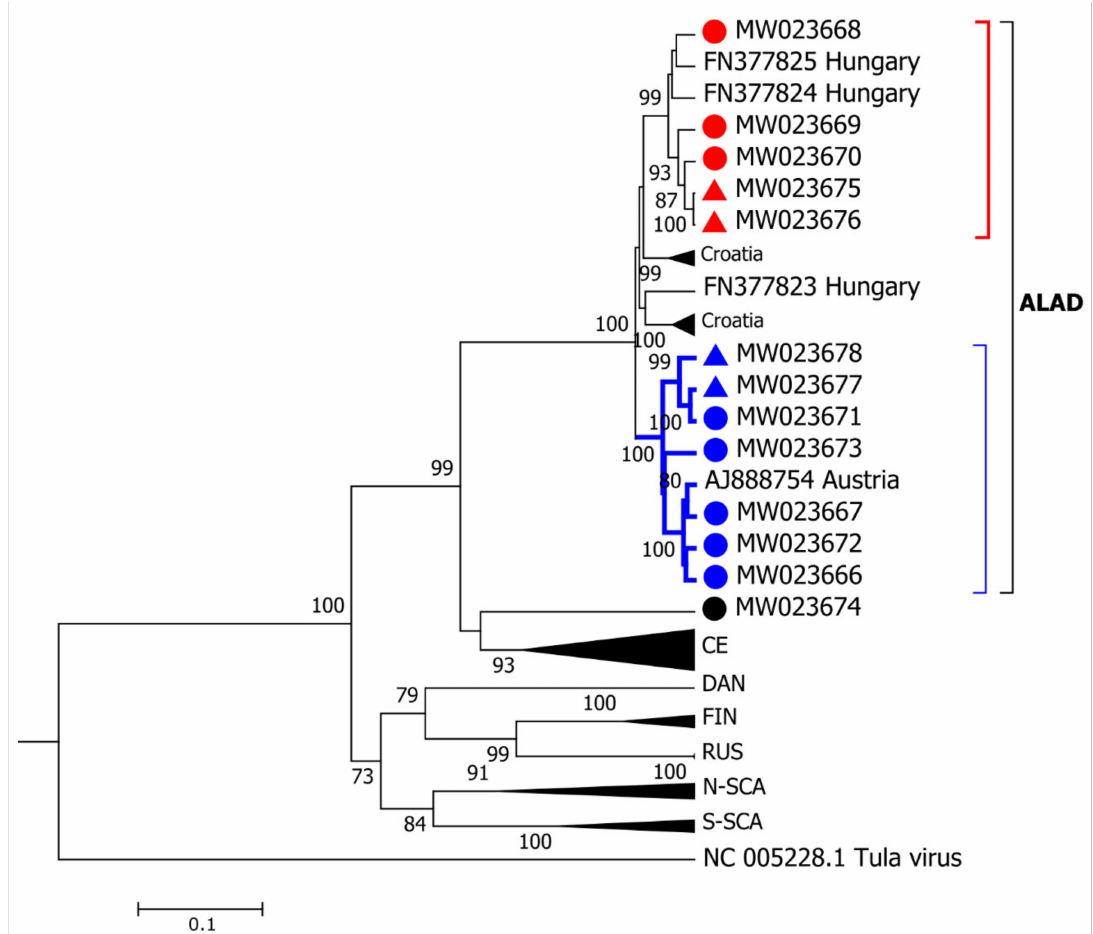
Figure 5. Phylogenetic tree (maximum clade credibility) of partial Puumala orthohantavirus (PUUV) M segments. The phylogenetic tree was inferred from 405 nt amplicons of PUUV M segments from human-patient material ( n = 9, filled circles) or reservoir host lungs ( Clethrionomys glareolus , filled triangles) using the GTR+G+I substitution model with four gamma categories. The closely related Tula orthohantavirus reference strain (NC_005228.1) was used as an outgroup. Posterior probabilities (as percent) supporting each node are displayed for all nodes with >65% support. Previously established lineages are collapsed and labelled (e.g., DAN, FIN, RUS, N-SCA, S-SCA). PUUV sequences from this study (labelled with GenBank Accession number) were identified as either Alpe-Adria (ALAD, bracket) or Central Europe lineage (CE), based on identity of previously published sequences (labelled with Accession number and country, or collapsed and labelled by country). Two ALAD genotypes were identified from the S segment phylogeny, pairwise evolutionary distances, and a deduced amino acid substitution at site 238 in the nucleocapsid protein; shown here in red (E238) and blue (D238). A potentially novel genotype of CE was discovered in the Austrian federal state of Carinthia (accession number